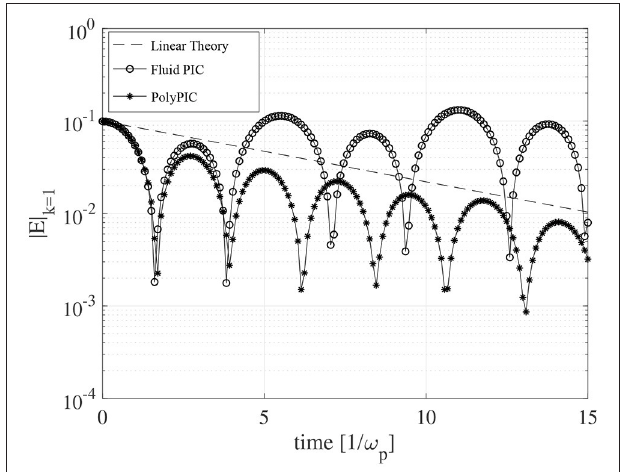
FIGURE 5 | Simulation of ion acoustic propagation in plasma using fully kinetic simulation (open circles), fluid electrons and kinetic ions (asterisks) and fully fluid (open squares) simulations.